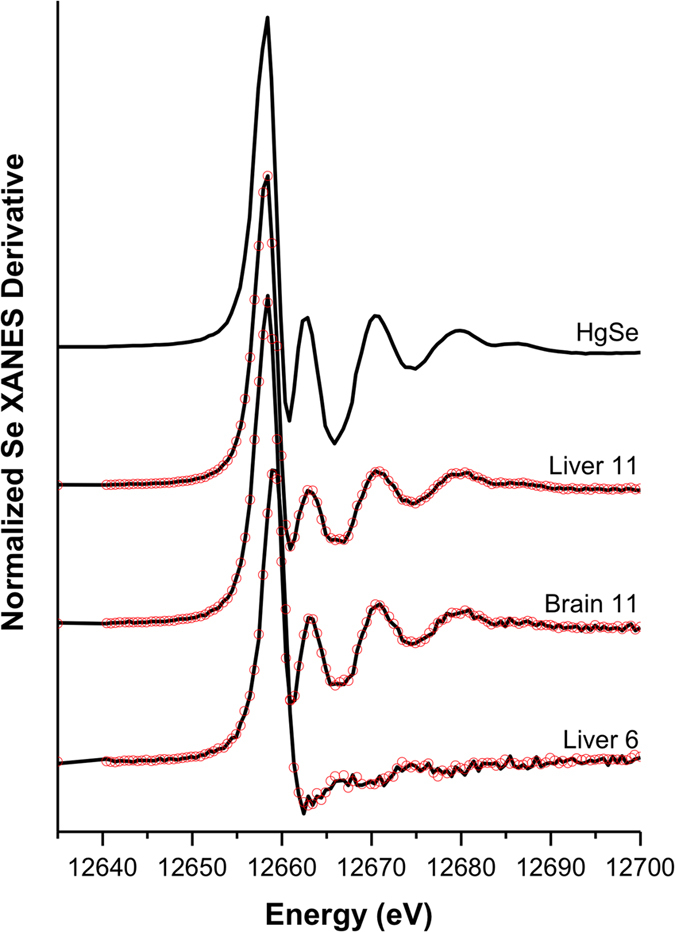
Identification of bioformed HgSe nanoparticles.Synchrotron-based XANES analyses show high similarities between Se signal generated by a HgSe standard and Se signal from the liver and brain of an adult whale (Liver 11, Brain 11), indicating high proportions of Se being locked in HgSe aggregates. Absence of HgSe aggregates was found in the juvenile liver (Liver 6) as Se signal doesn’t show similarities with HgSe standard. Black solid lines show the experimental data and red dots are the best fit of the linear combination fitting.